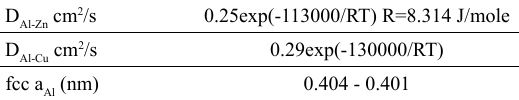
Table 2. Diffusion coefficients and lattice parameter 11,12